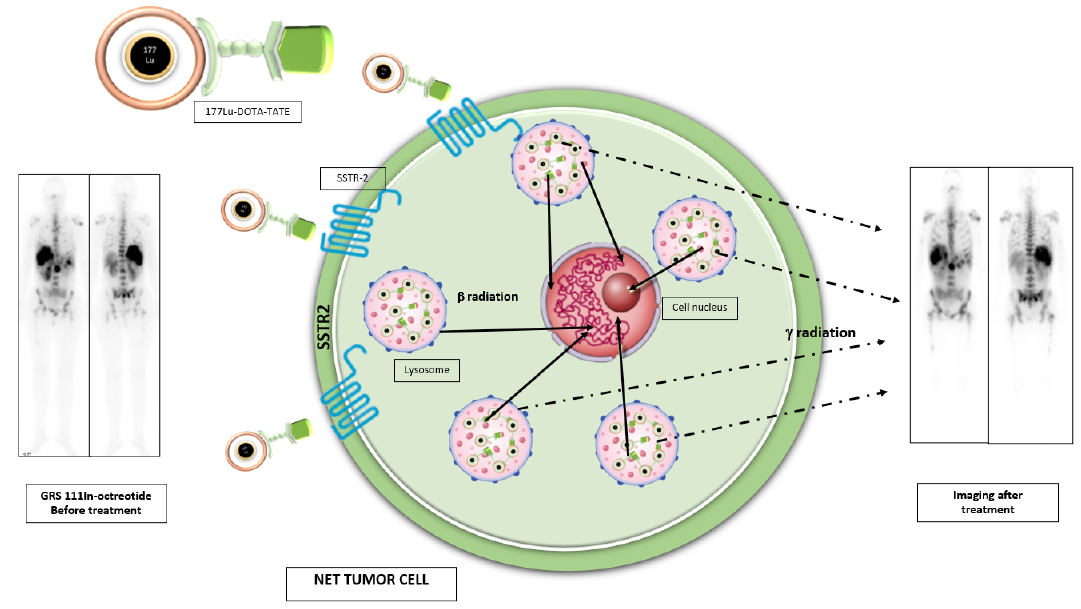
Figure 4. Schematic representation of PRRT-Lu treatment and whole body distribution scan 24 h post-PRRT treatment. The development of analogue [DOTA]0-Tyr3-octreotate or DOTATATE labeled